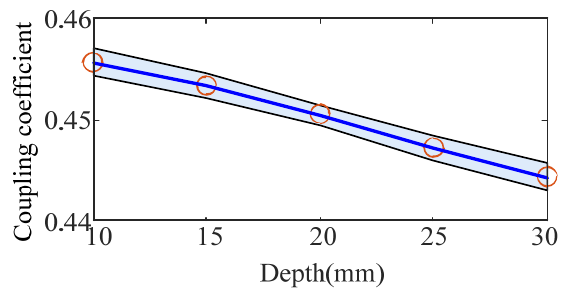
Figure 7. Fitting curve with different distances.